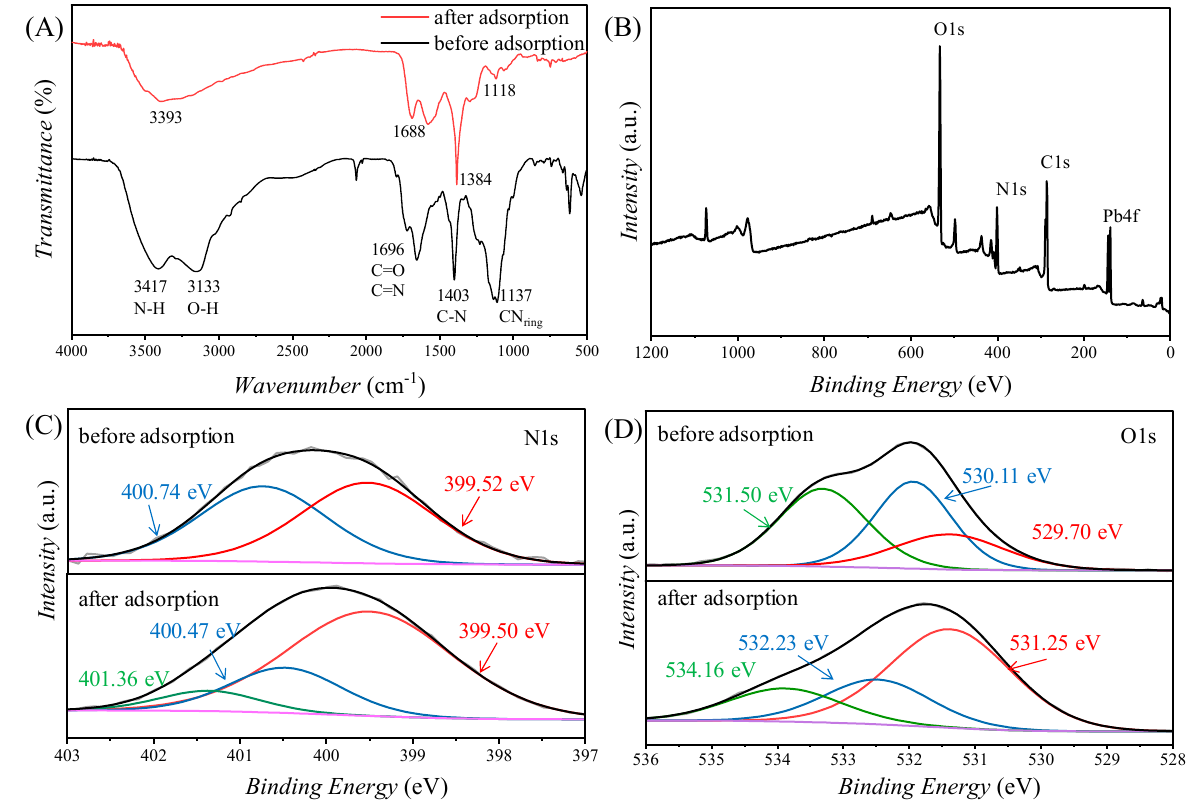
located at 531.39/531.25, 531.94/532.23 and 533.31/534.16 eV, which could be assigned to C=O, C–O and O–H bonds, respectively [54]. The shift and change in the intensity of the Figure 5. ( A ) FTIR spectra, ( B ) XPS survey and high resolution XPS spectra of ( C ) N1s and ( D ) O1s binding energy of the subdivided peaks proved that the coordination of Pb(II) with oxygen atoms occurred during adsorption [55]. Figure 6 vividly illustrates a possible adsorption of PAA sponge after adsorption of Pb(II). mechanism between nitrogen atoms and the oxygen atoms of the PAA sponge forming strong coordination complexes with Pb(II). In summary, the efficient adsorption of Pb(II) by the PAA sponge was due to the synergy of physical adsorption and chemical adsorption.